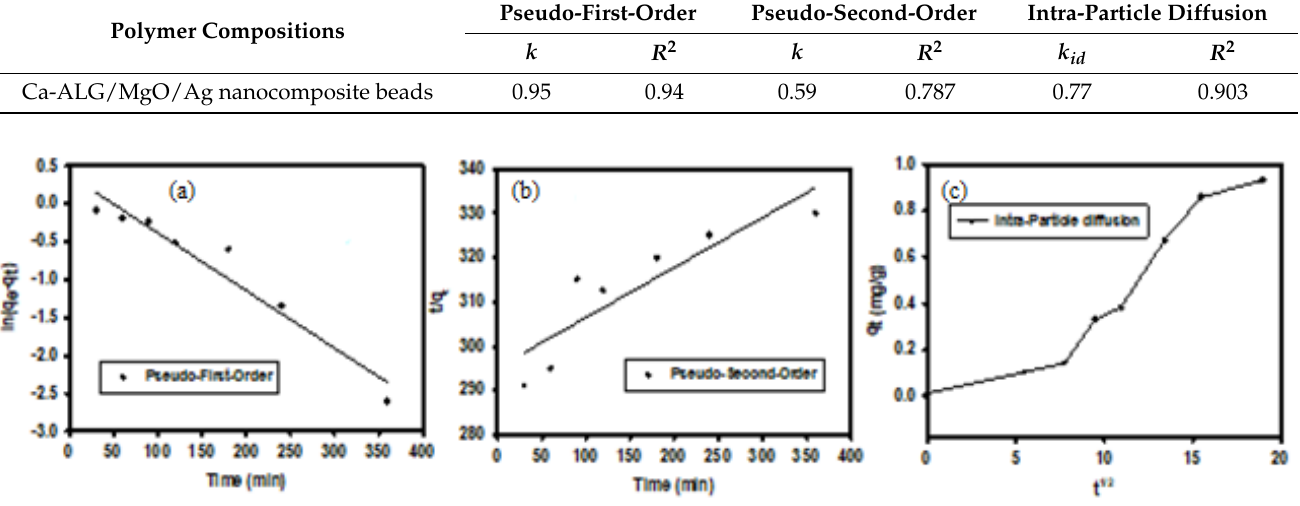
Figure 9. ( a ) pseudo-first-order kinetics, ( b ) pseudo-second-order kinetics, and ( c ) intra-particle dif- fusion model of Direct Red 83 dye degradation . Table 1. kinetic parameters: pseudo-first-order kinetics, pseudo-second-order kinetics, and intra- particle diffusion model of Direct Red 83 dye